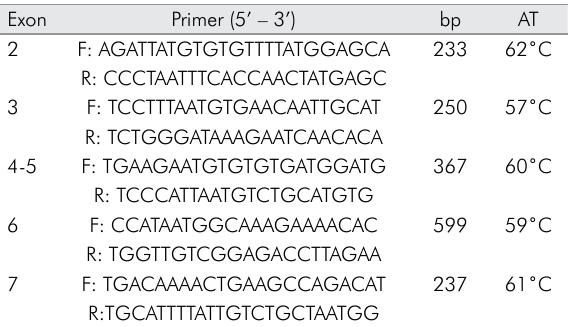
Table 1. Sequence of forward and reverse primers designed for exons 2, 3, 4,5, 6 and 7 of AMELX and PCR